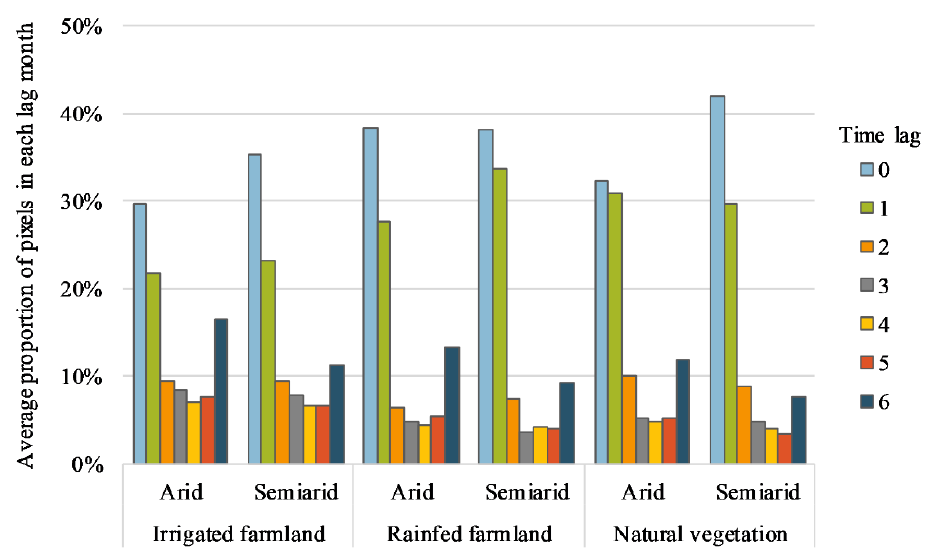
Figure 6. The average proportion of pixels in each lag month. (Only pixels with statistically significant correlation coefficients were considered.).